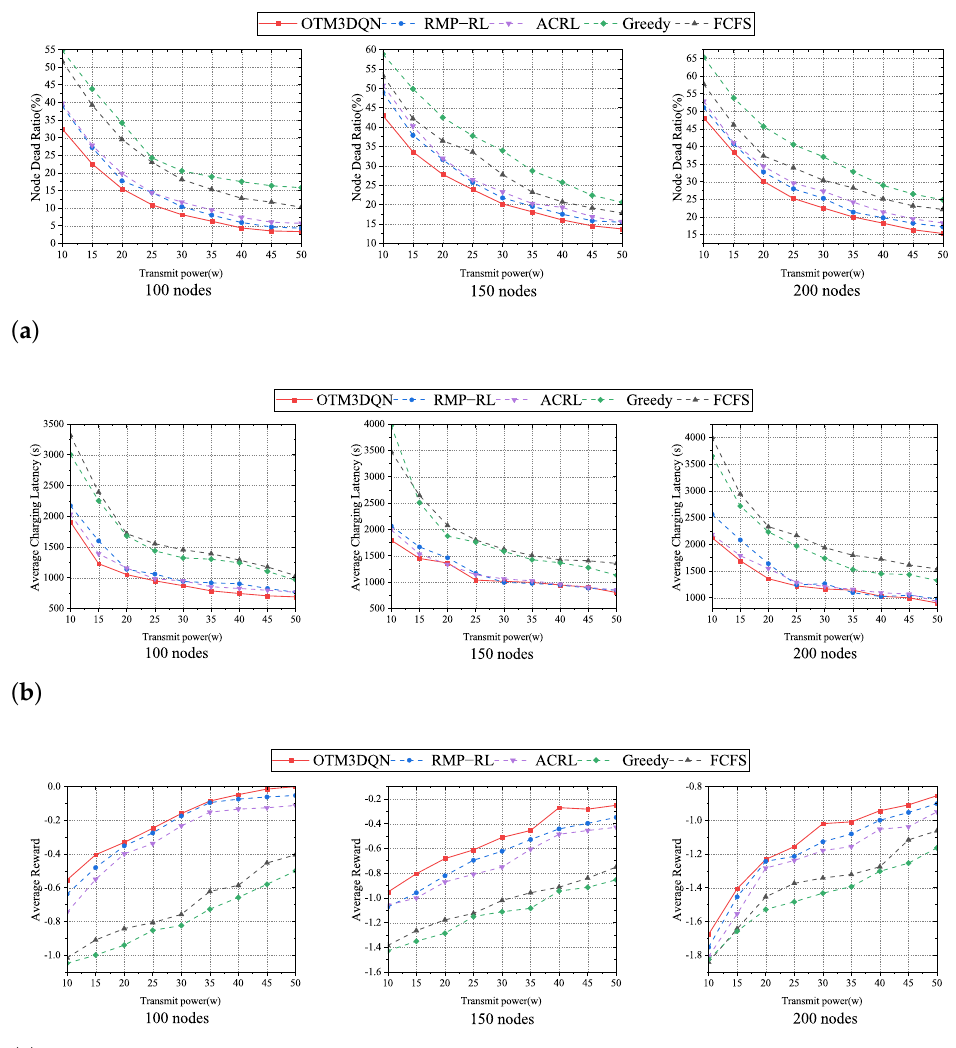
Figure 7. Impact of MC transmitting power. ( a ) Node dead ratio under different MC transmitting power. ( b ) Average charging latency under different MC transmitting power. ( c ) Average reward under different MC transmitting